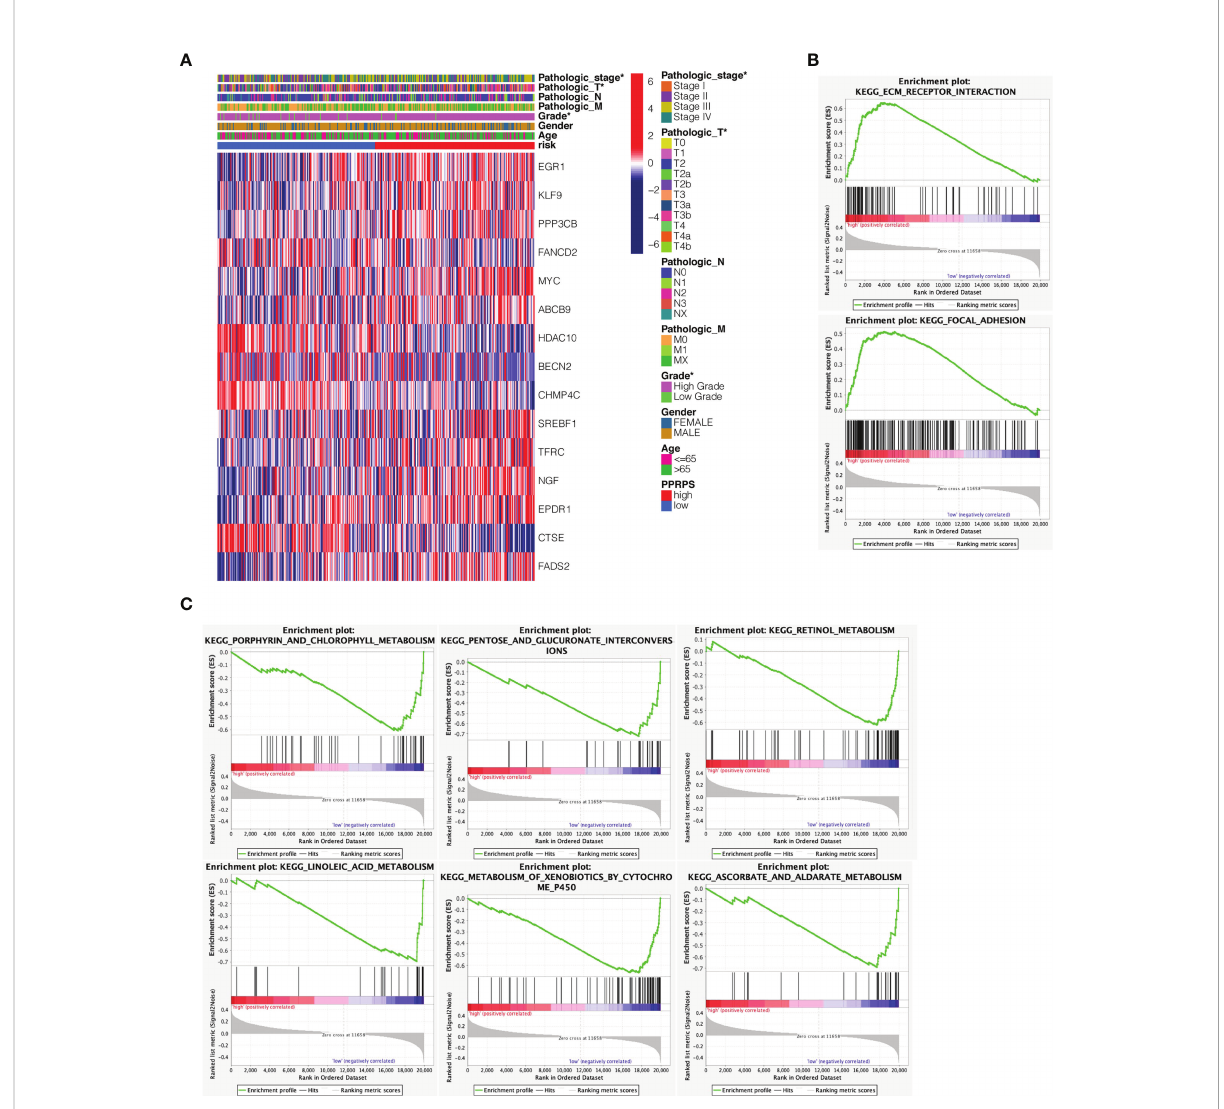
FIGURE 5 Clustering of tumor samples based on Pan-PCD DEGs and functional analysis of the prognostic model. (A) Relevance between the PPRPS and clinical features among 16 DEGs. The pathologic stage, T stage and pathological grade differed between the low- and high-PPRPS subgroups (P < 0.05). (B) Pathways enriched in the high-PPRPS group. (C) Pathways enriched in the low-PPRPS